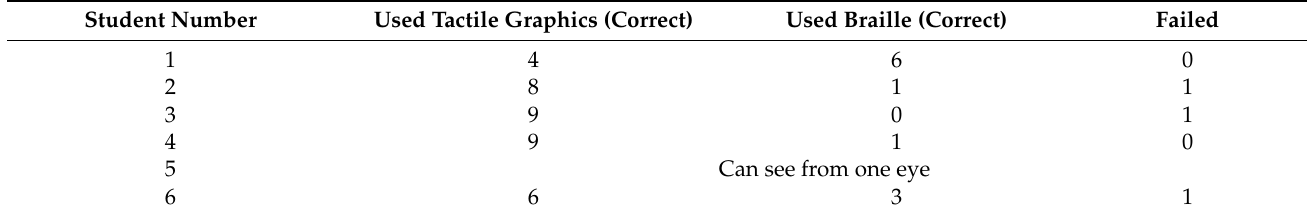
Table 7. Testing with the tactile flashcards.